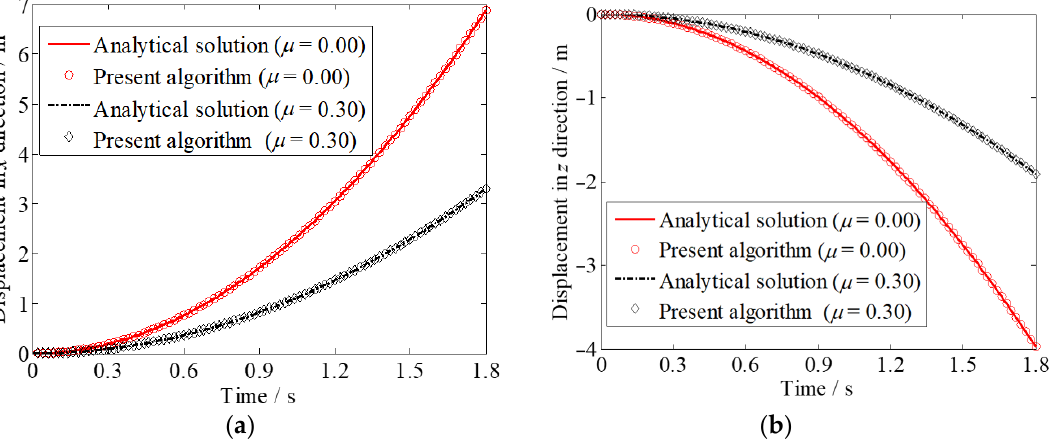
Figure 6. Comparison of the displacements of the block calculated by the analytical method and the present algorithm: ( a ) Displacement in x -direction; ( b ) Displacement in z -direction.